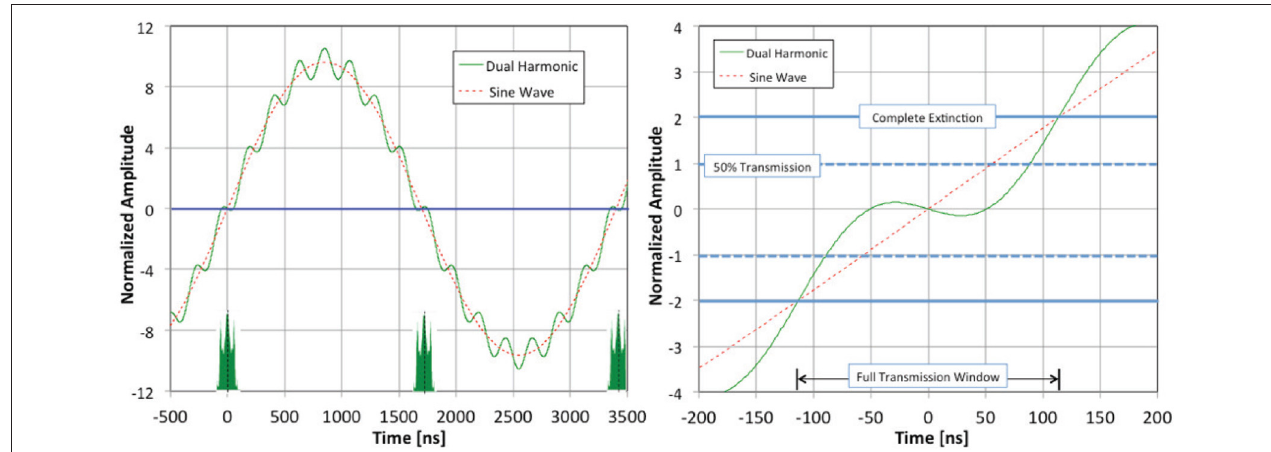
FIGURE 6 | Displacement of the beam by the AC dipole vs. time. Recall that the AC dipole system sweeps out-of-time beam into collimators. The left-hand plot shows the normalized amplitude of the field and the right-hand shows the normalized amplitude of the displacement. The units of displacement are “normalized deflection”: δ = 1 means the center of the beam is deflected to the edge of the collimators, implying 50% transmission. At δ = 2 the entire beam will be deflected into the collimators. Inset in the left-hand side is the location in time of the proton pulse and its expected shape. Updated from Bartoszek et al. [8], courtesy of E. Prebys and the Mu2e